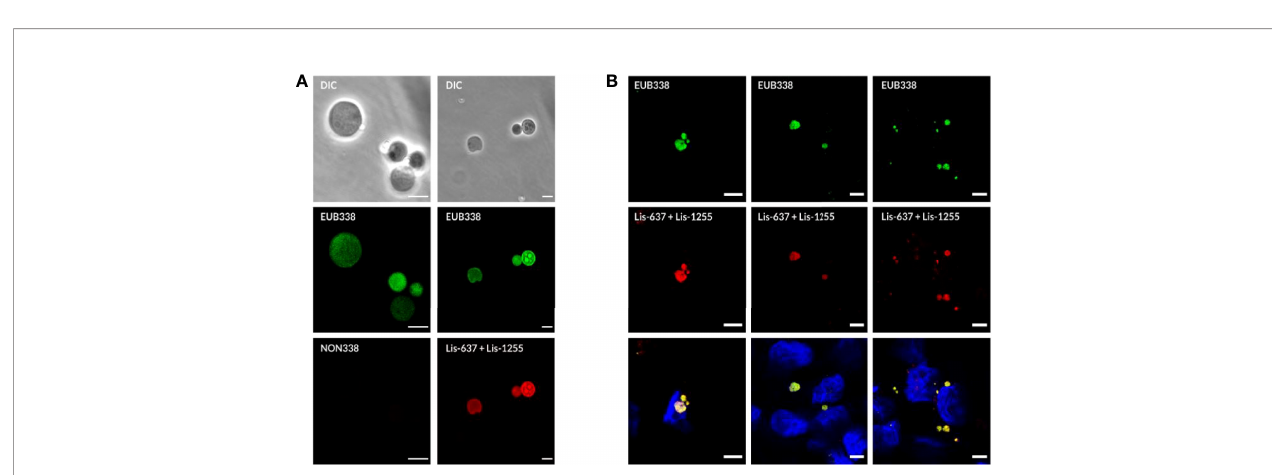
FIGURE 4 | Detection of intracellular L-forms inHBME cellsafter Ampicillin treatment using fl uorescence in-situ hybridization (FISH). (A) FISH analysisofa pure culture of revertant strainRev10 L-forms. Hybridization with universal probeEUB338 (green)and Listeria genus-speci fi c probes Lis-637 andLis-1255 (red)resulted inrespective fl uorescence signals(right column). The absence ofa signal after hybridization with probe NON338 (leftcolumn), used as a negativecontrol, indicated that the observed signals are not due to background fl uorescence or unspeci fi c binding of probes. (B) FISH analysisofHBME cells after infection with Listeria monocytogenes strains Rev10 (left) andRev19 (middle),as well as an L. ivanovii revertant strainRev1(right) and subsequent treatment with Ampicillin (200 µg/ml)for 14 days. Hybridization with universal probe EUB338 (green) and Listeria genus-speci fi c probes (red) identi fi ed the sphericalstructures inside HBME cellsas Listeria L-forms. In the lower row the nucleusof HBME cells isstainedin blue andL-forms show a yellow fl uorescencedue to superimposition of the red signal fromthe Listeria genus-speci fi c probes with thegreen signalfrom universal probe EUB338. Scalebar = 5 µm.